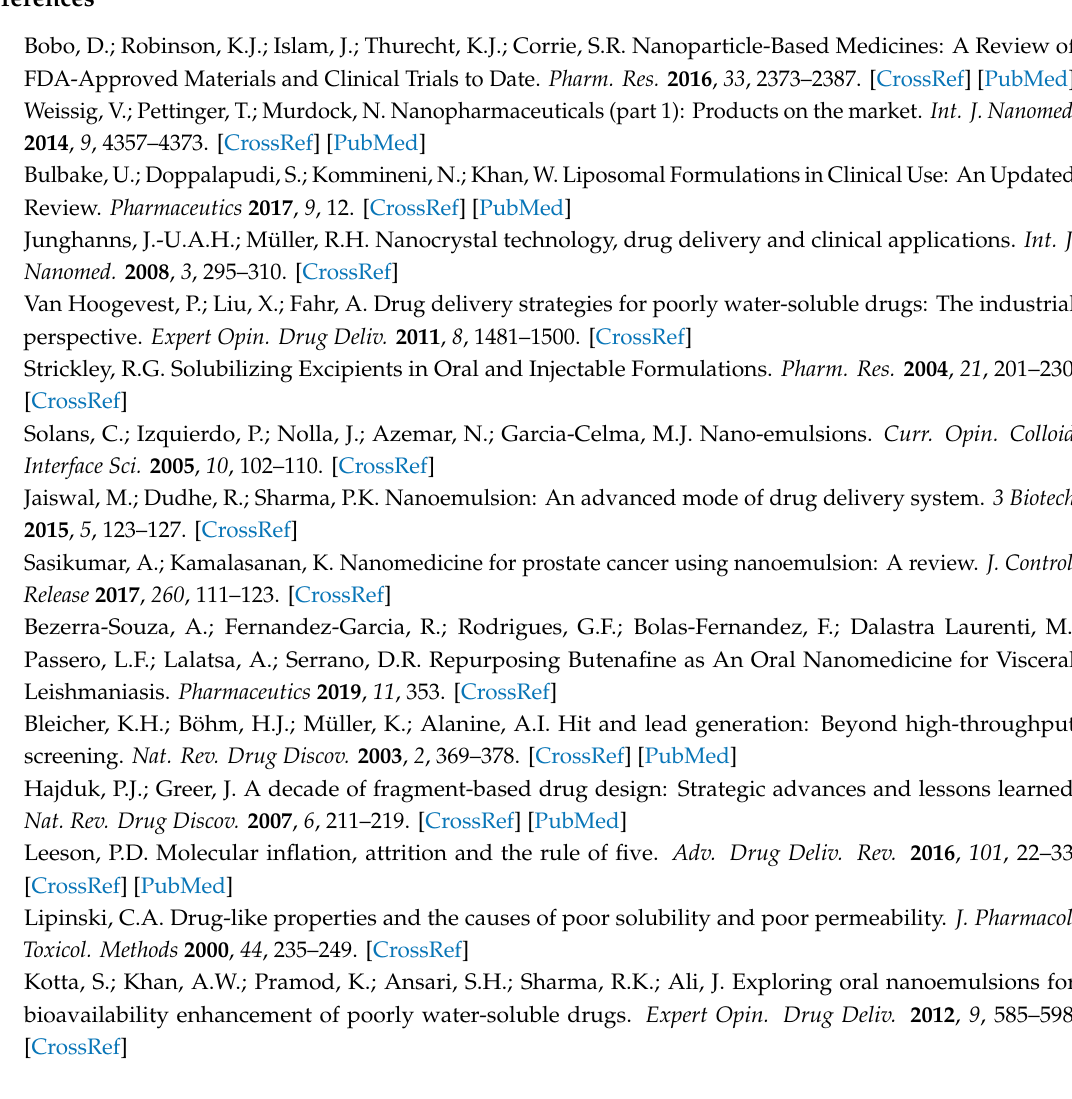
Figure S1: Results of the haemolysis test for the chosen excipients, Table S1: Mixture design comprising 12 experiments where the central point was triplicated, Table S2: Names, structures and characteristics of tested